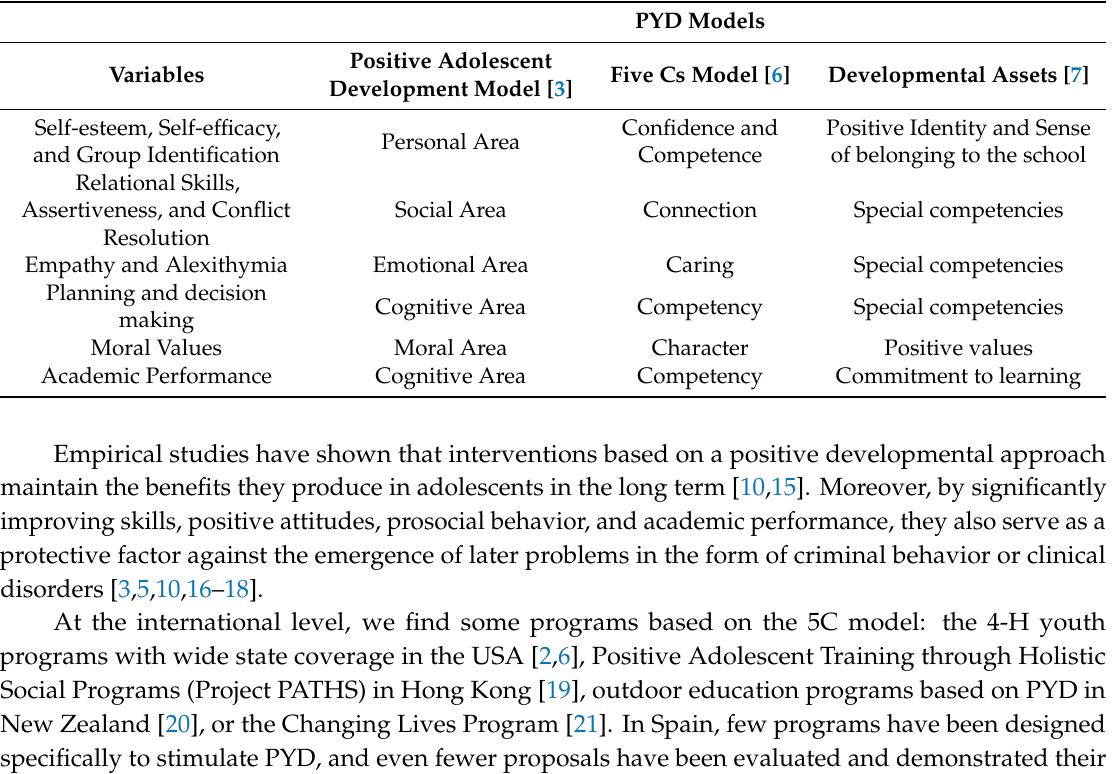
Table 1. Relevant study variables based on PYD